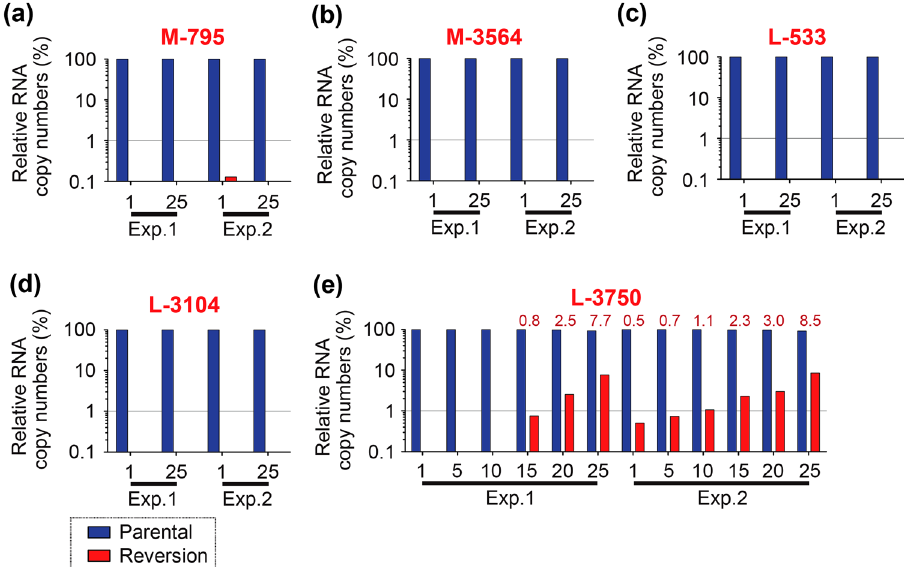
Fig. 3 Detection of reversion mutants of the MP-12 vaccine during viral passages in Vero cells. The MP-12 vaccine was passaged 25 times in Vero cells at MOI of 0.01 or less at 3 days post infection. Virus RNA was puri fi ed from culture supernatants and analyzed for the presence